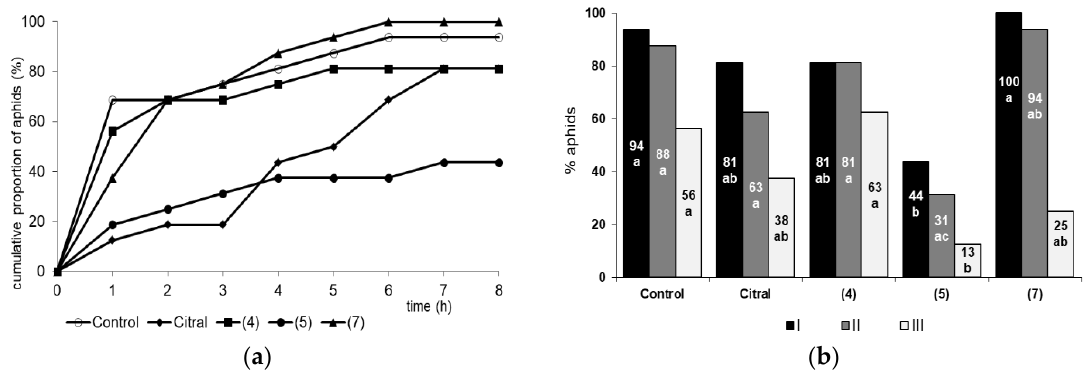
Figure 3. Myzus persicae success rate in finding phloem sieve elements and feeding on phloem sap on plant leaves treated with citral and citral-derived lactones: ( a ) Cumulative proportion of aphids that reached sieve elements during the 8-h access to plants. ( b ) Proportion of aphids that reached sieve elements (I), showed sustained sap ingestion E2 > 10 min (II), and showed sustained sap ingestion during the first probe (III); β , γ -dimethyllactone ( 4 ), α -methylenelactone ( 5 ), α , γ -dimethylenelactone ( 7 ); n = 16; di ff erent letters show significant di ff erences among aphids on plant leaves treated with citral and citral-derived lactones at p < 0.05 (Kruskal–Wallis